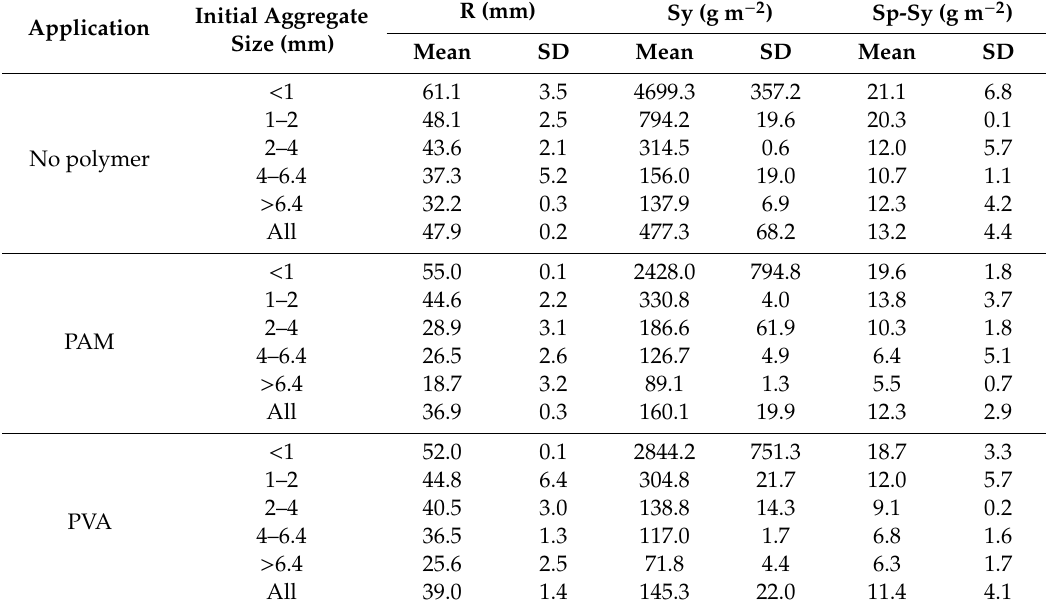
Table 3. Mean values of soil and water losses under sequential simulated